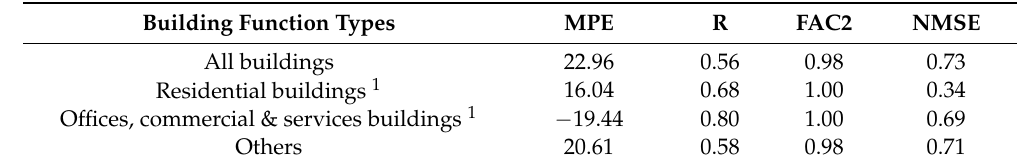
Table 5. Statistical analysis of 131 buildings.